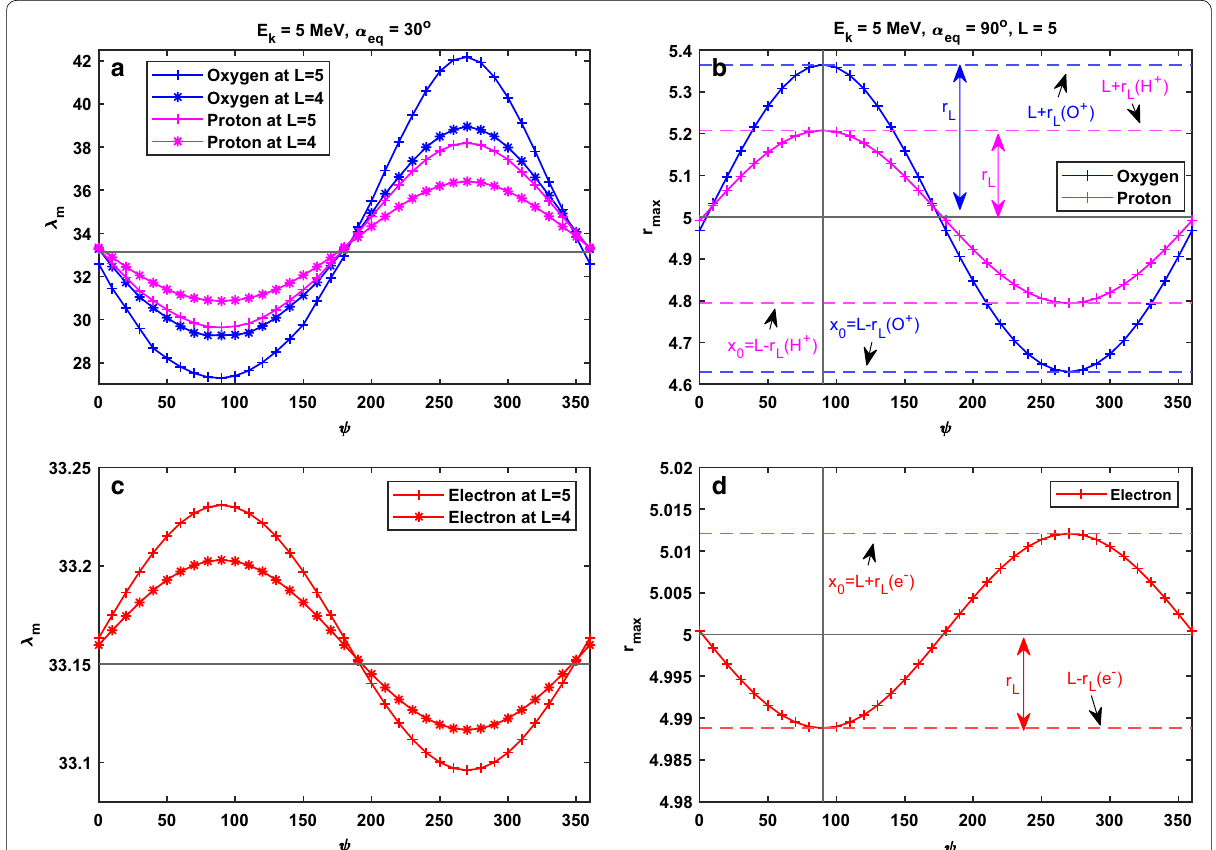
Fig. 2 Magnetic mirror point latitude ( (cid:31) m ) as a function of initial gyro-phase ( ψ ) for ( a ) oxygen (blue), and proton (magenta) ( c ) electron (red) of energy 5 MeV, L = 4 and 5, and α eq = 30 ◦ . Maximum radial distance at equator ( r max ) as a function of initial gyro-phase ( ψ ) for ( b ) oxygen, and proton of energy 5 MeV initially placed at x 0 = L − r L ( d ) electron of energy 5 MeV initially placed at x 0 = L + r L with L = 5 , and α eq = 90